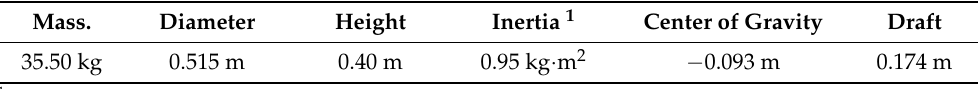
Figure 4. Schematics and dimensions of the adopted mooring configurations: ( a ) top view of the setup; ( b ) configura- tion consisting of standard catenary cables (CAT); ( c ) configuration consisting of synthetic cables and floaters (CON1); ( d ) configuration consisting of synthetic cables, floaters and clump weights (CON2). Table 1. Particulars of the moored